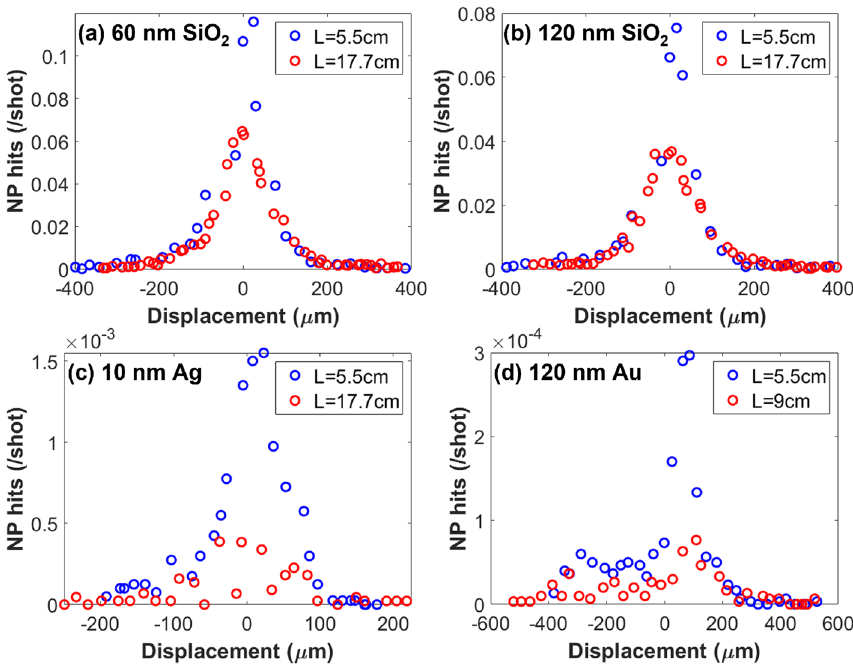
Figure 3. 1D scans of NP hits per laser shot for ( a ) 60 nm SiO 2 , ( b ) 120 nm SiO 2 , ( c ) 10 nm Ag, and ( d ) 120 nm Au taken with a main chamber pressure of 3.5e-4 Torr. Each subfigure presents scans for both the smallest and largest L value that a scan was performed at. The atomized NP concentration for ( a ) – ( d ) are, respectively: 5.0e13, 6.3e12, 4.0e12, and 2.1e9 NP/mL. CEM signals were recorded for 5e3, 5e3, 5e4, and 3e5 laser shots for each step of the motorized mirror in ( a ) – ( d )